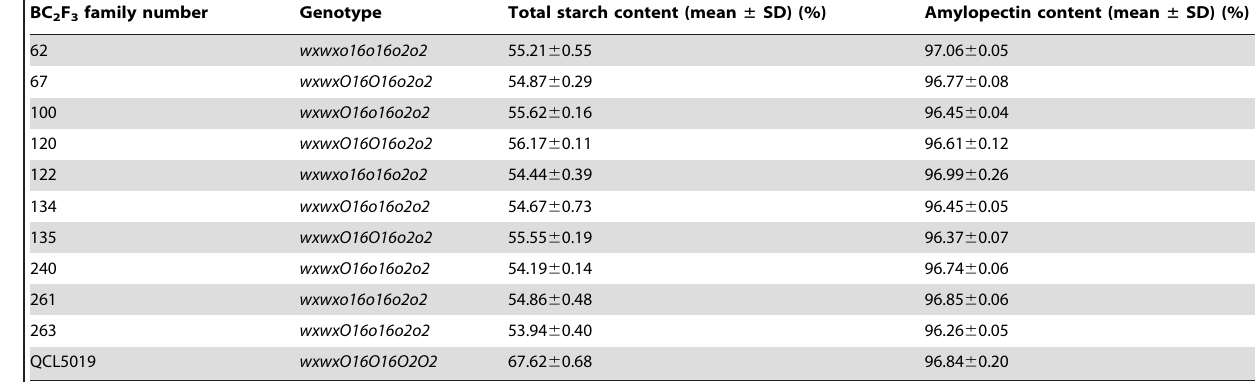
BC 2 F 3 family